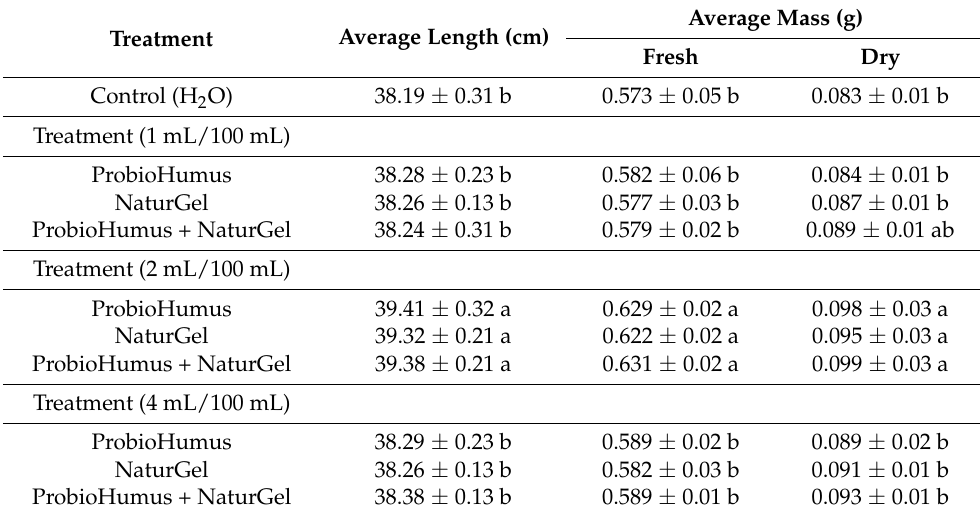
Table 2. Effect of leaf-sprayed probiotic preparations on morphometric parameters of winter wheat seedlings (per plant) grown under controlled laboratory conditions.